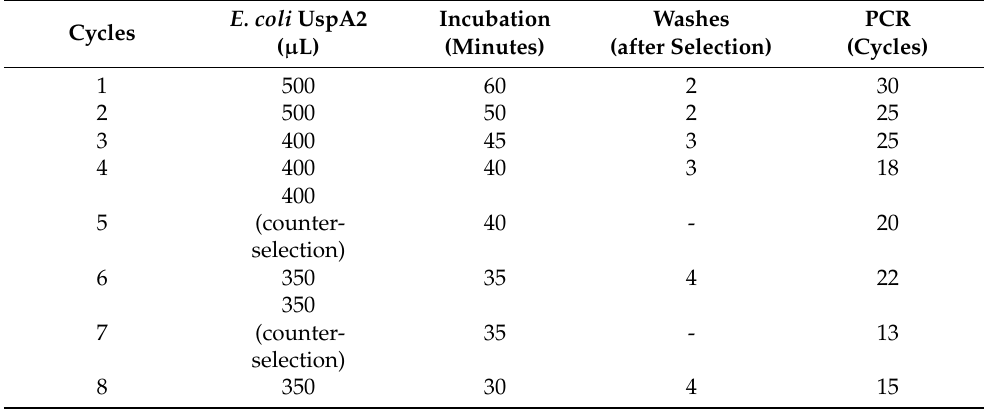
Table 1. Conditions used in the 8 cell-systematic evolution of ligands by exponential enrichment (cell-SELEX) selection cycles performed to isolate aptamers with high affinity to UspA2 from Moraxella catarrhalis . E. coli UspA2 Incubation Washes PCR Cycles ( µ L) (Minutes) (after Selection) (Cycles) 1 500 60 2 30 2 500 50 2 25 3 400 45 3 25 4 400 40 3 18 400 5 (counter- 40 - 20 selection) 6 350 35 4 22 350 7 (counter- 35 - 13 selection) 8 350 30 4